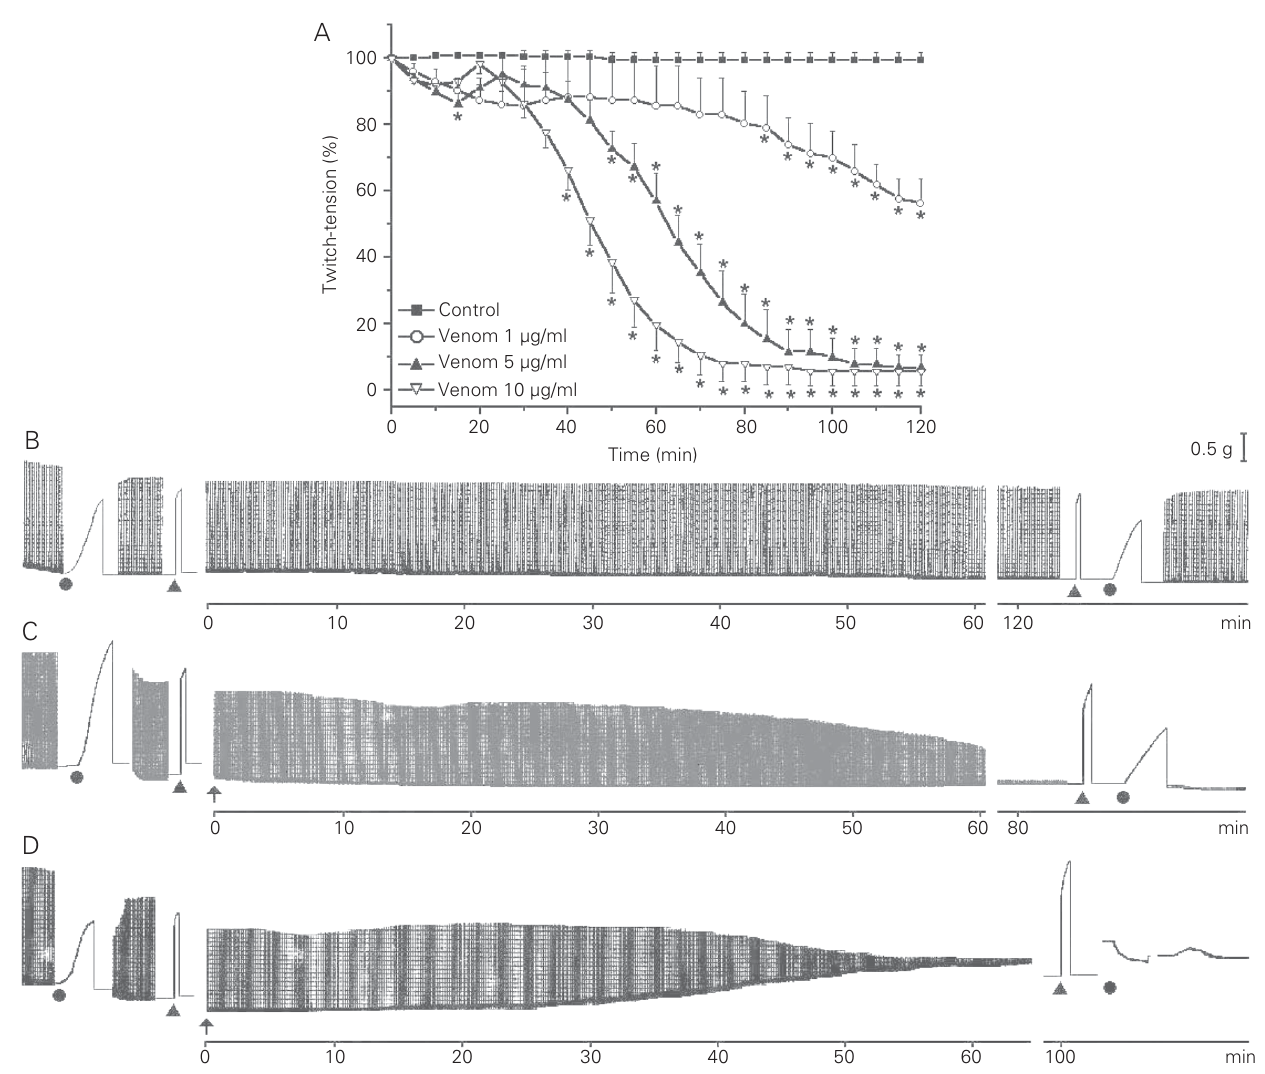
Figure 1. Effect of low concentrations of Bothrops neuwiedii pauloensis venom (1, 5 and 10 µg/ml) on chick biventer cervicis nerve-muscle preparations at 37 (cid:1) C. A , Concentration-time response curves for the neuromuscular blocking activity of the venom compared to Krebs solution alone (control). Each point represents the mean ± SEM of 3-6 experiments. B , Twitch-tension responses by a control (Krebs solution alone) preparation. C and D , Venom- treated preparations (5 and 10 µg/ml, respectively). B.n. pauloensis venom was added (arrow) after allowing the preparations to stabilize for 15 min. Note the contracture induced by 10 µg of venom/ml. The responses to exogenous 110 µM acetylcholine (triangles) and 13.4 mM KCl (circles) were obtained before and after the addition of venom. These results are representative of 3-6 experiments per venom concentration. *P<0.05 compared to the control preparations (Student t